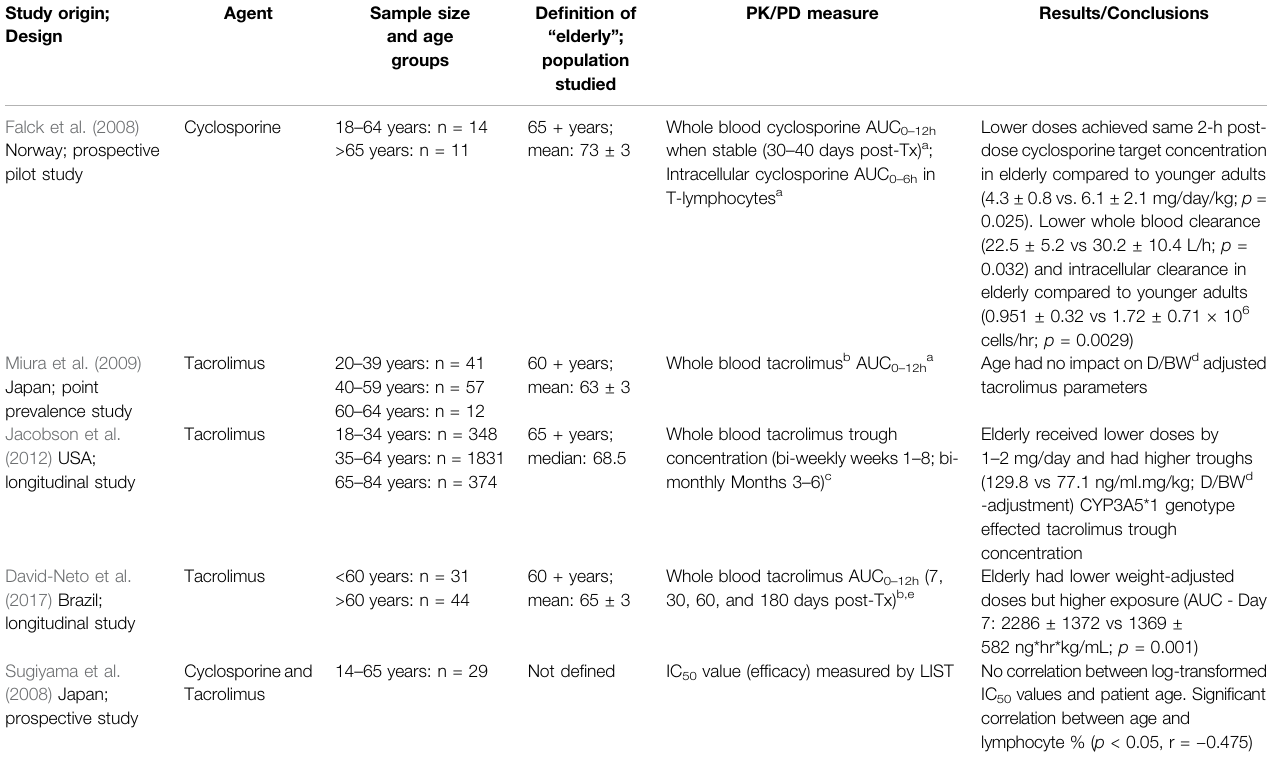
TABLE 1 | A summary of pharmacokinetic and pharmacodynamic studies of calcineurin inhibitors in the elderly. Study origin;